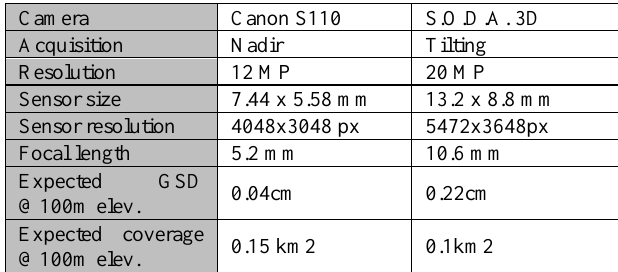
Table 1. Comparison between Canon S 110 used during the 2015 survey campaign and the S.O.D.A